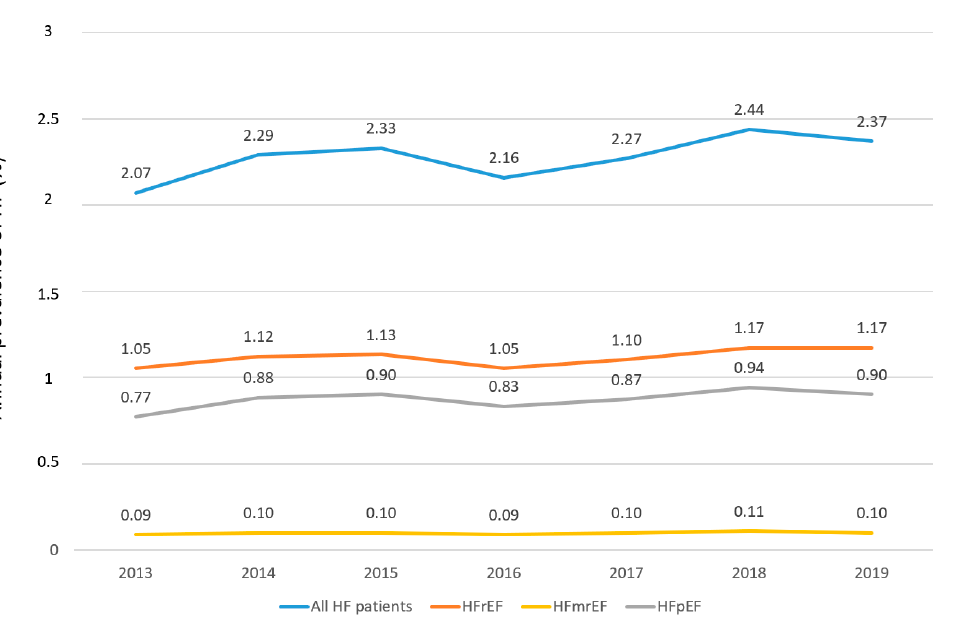
Figure 1. Incidence rates of HF. Abbreviations: HF = Heart failure; HFmrEF = Heart failure with mildly reduced ejection fraction; HfpEF = Heart Failure with preserved ejection fraction; HFrEF = Heart failure with reduced ejection fraction; HfuEF = Heart Failure with un-specified ejection frac- tion. Data were recorded until September 2019.